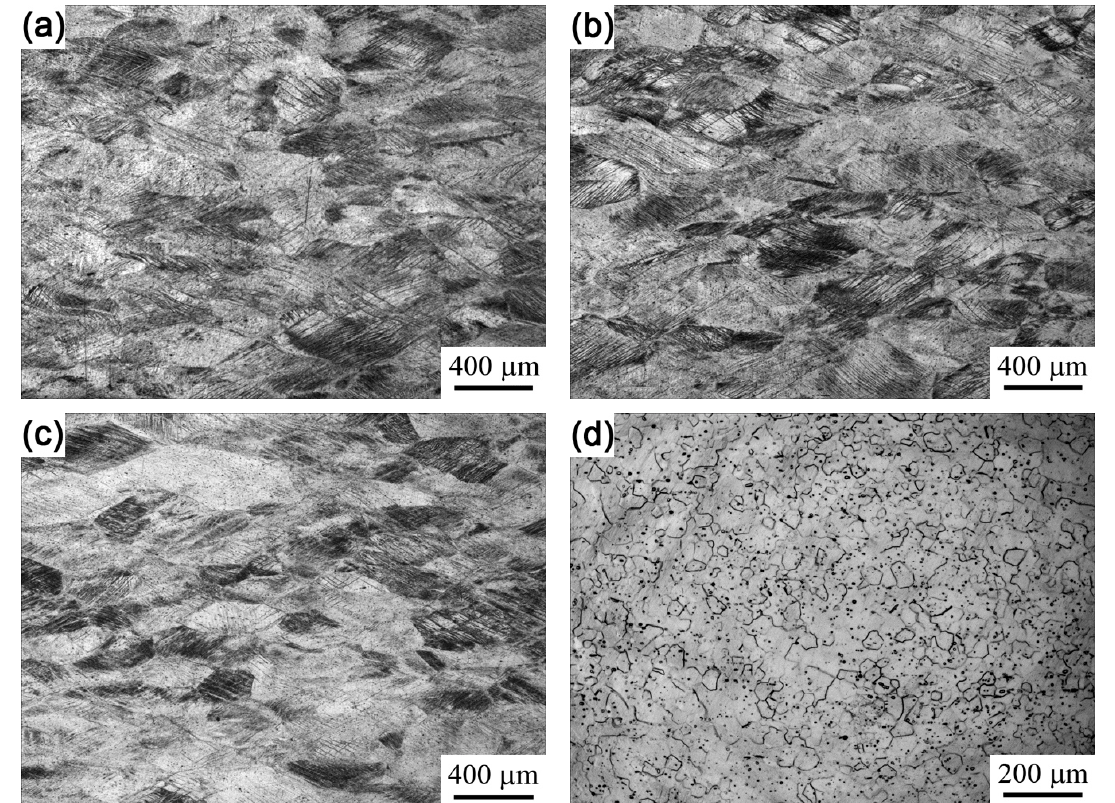
Figure 2. OM microstructure of the specimens after electropulsing treatment at 2 kV ( a ), 4 kV ( b ), 6 kV ( c ), and 8 kV s ( d ). 6 kV ( c ), and 8 kV s ( d